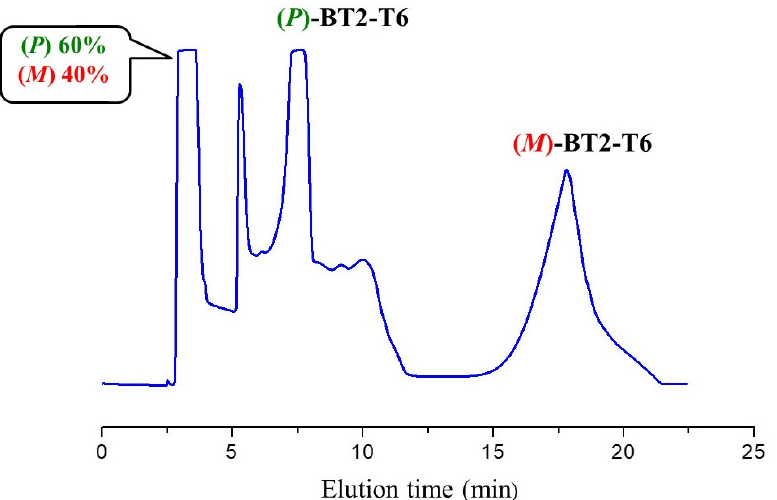
Figure 4. Aberration on the HPLC chromatogram after injection of 3.34 mg of rac ‐ BT2 – T6 in 500 μ L. of dichloromethane. Chromatographic conditions: column, Chiralpak IB (250 × 10 mm, 5 μ m); mo ‐ bile phase, n ‐ hexane–methanol–dichloromethane 90:5:5 ( v / v / v ); column temperature, 15 °C; flow rate, 5.5 mL min − 1 ; detection, UV at 360 nm.